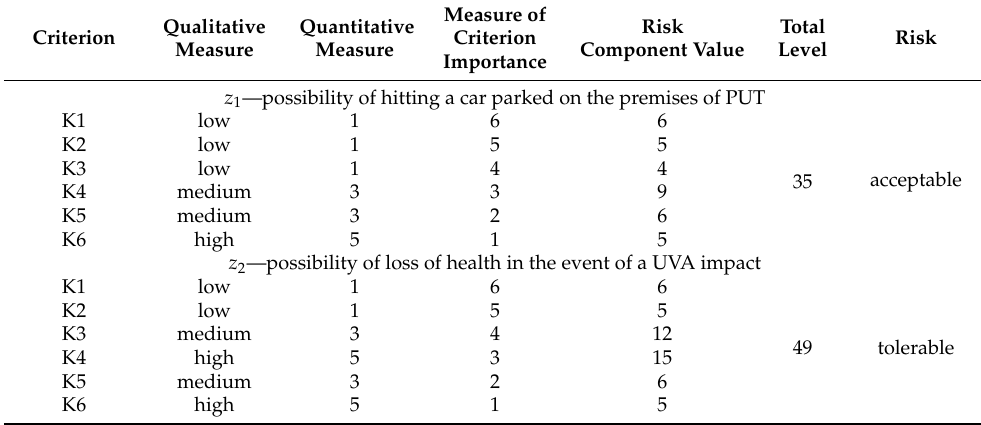
Table 3. Summary of the results of the risk assessment of selected threats generated during the flight in